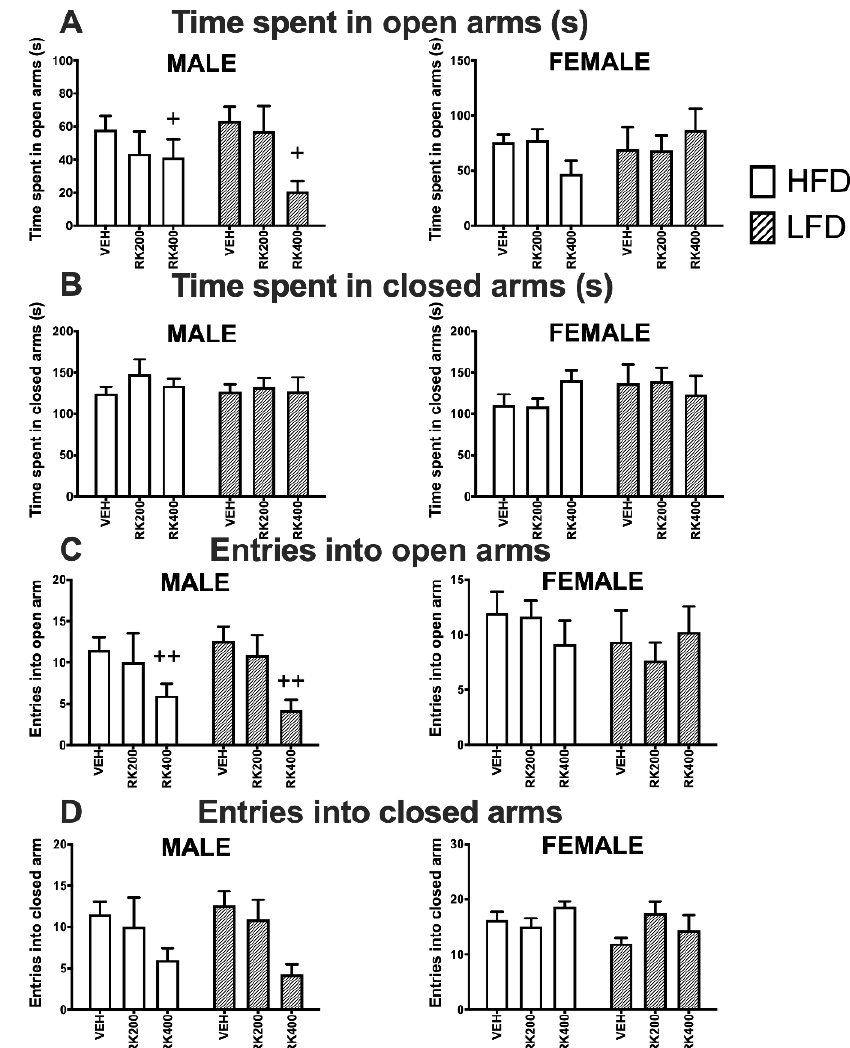
Figure 4. Elevated plus maze behavior test during daily oral RK and diet access. Elevated plus maze tests were performed during days 19–21 of daily dosing and diet access. Data are represented as means ± standard error of the mean (SEM). High-fat diet (45% fat; HFD, solid lines) and low-fat diet (10% fat; LFD, stripped line) and oral dosed with raspberry ketone (RK) or vehicle (50% propylene glycol, 40% water, and 10% dimethyl sulfoxide; DMSO). Comparisons are separate within each sex. ( A ): Time spent in open arms (s), ( B ): time spent in closed arms (s), ( C ): number of entries into open arms, ( D ): number of entries into closed arms. + indicates overall dose di ff erence from VEH dose ( p < 0.05), ++ indicates overall dose di ff erence from VEH dose ( p < 0.01). HFD-Vehicle (males: n = 15, females n = 8), HFD-RK (200 mg / kg) (males: n = 7, females: n = 8), HFD-RK (400 mg / kg) (males: n = 8, females: n = 7), LFD-Vehicle (males: n = 16, females: n = 8) LFD-RK (200 mg / kg)(males: n = 8, females: n = 8), and LFD-RK (400 mg / kg)(males: n = 8, females: n =